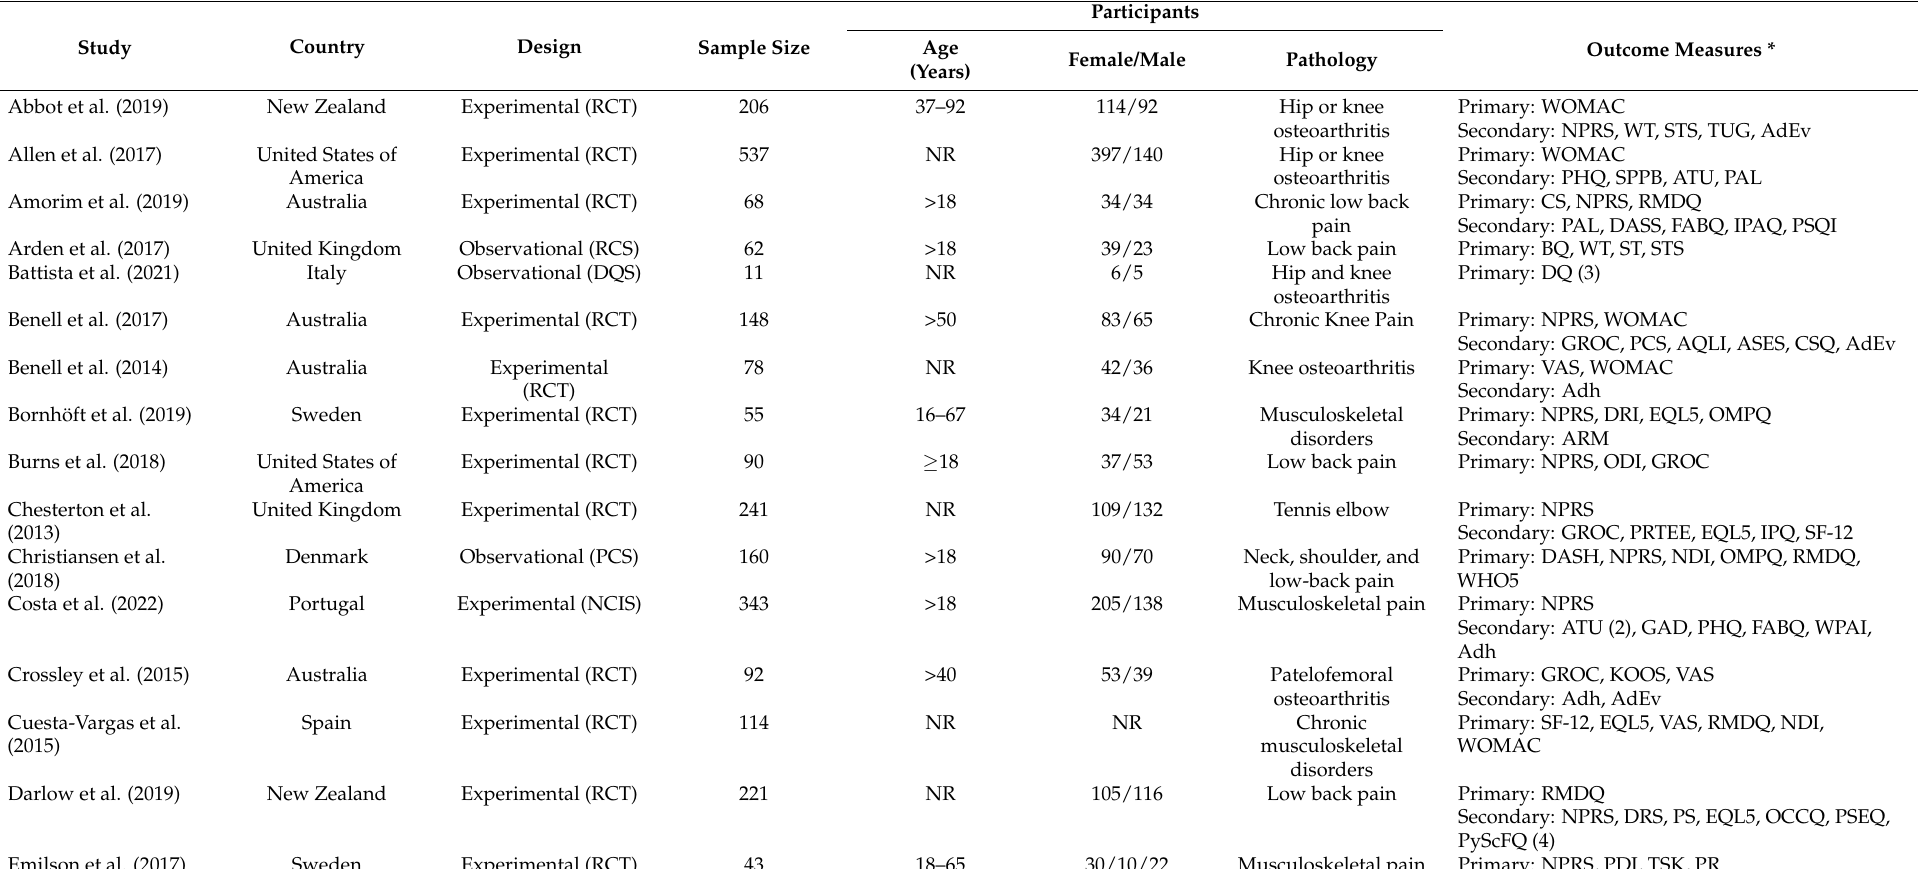
Table A1. Characteristics of Included